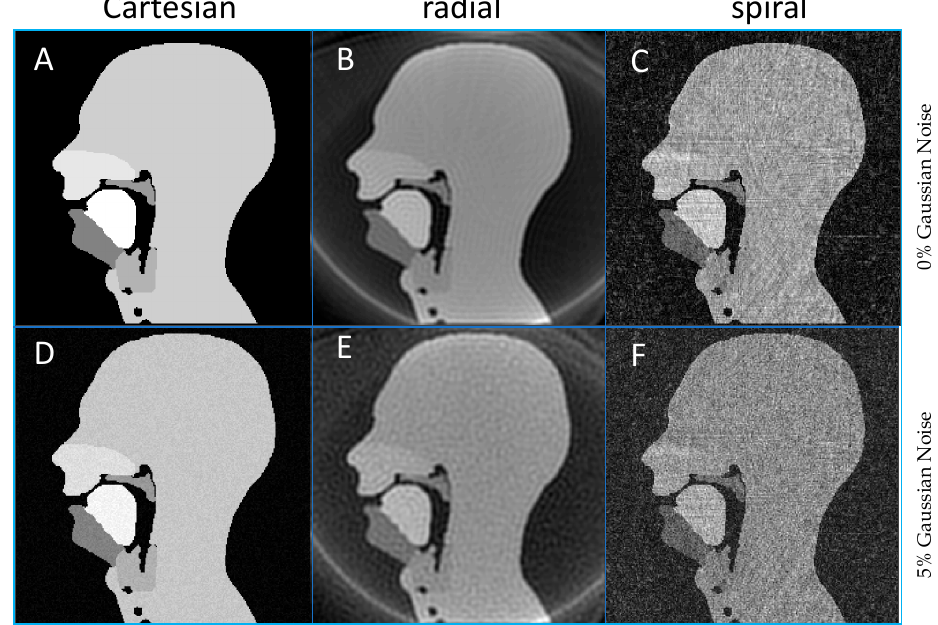
Figure 9. Example frames for a fully sampled k-space using different trajectories and noise level. ( A , D ) Cartesian, ( B , E ) radial, ( C , F ) spiral acquisitions with 0% ( A – C ) and 5% ( D – F ) noise added prior to Fourier transformation.